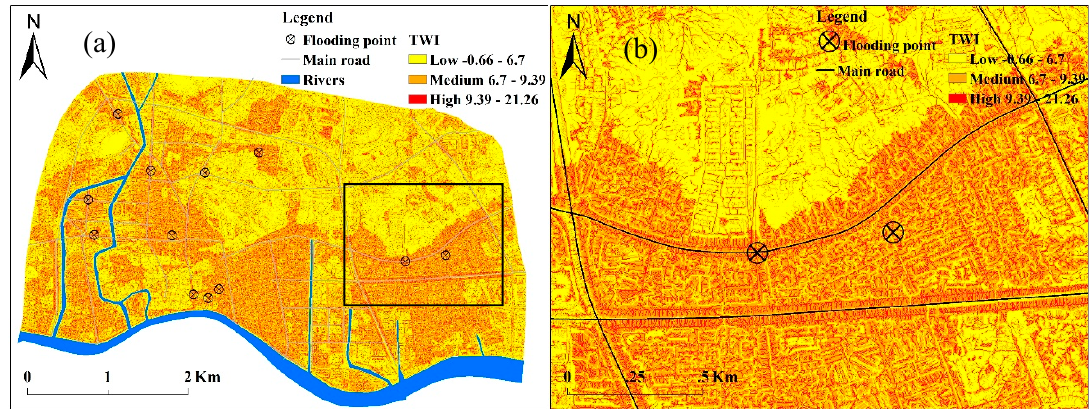
Figure 6. The spatial distribution of TWI in the study area ( a ), and the part in the rectangle ( b ) that has two flooding points. TWI values are divided into three groups: Low (yellow, TWI ≤ mean), Medium (orange, mean < TWI ≤ mean + standard deviation), and High (red, TWI > mean + standard deviation).